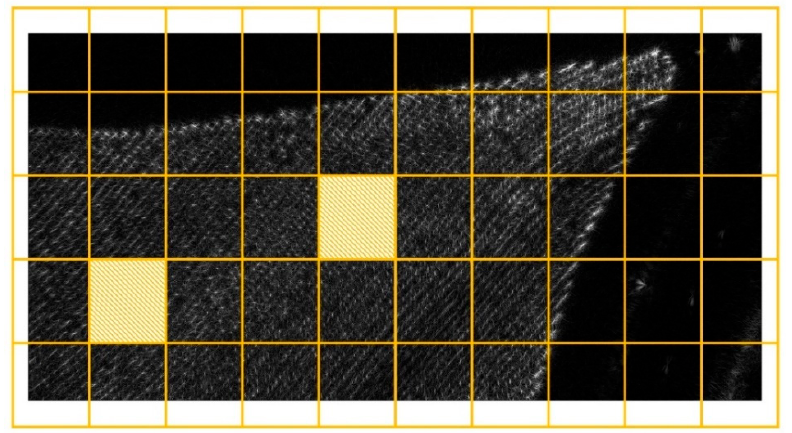
Figure 8. An illustration of the selected image blocks for analyzing the phase error as a function of geometric parameters.